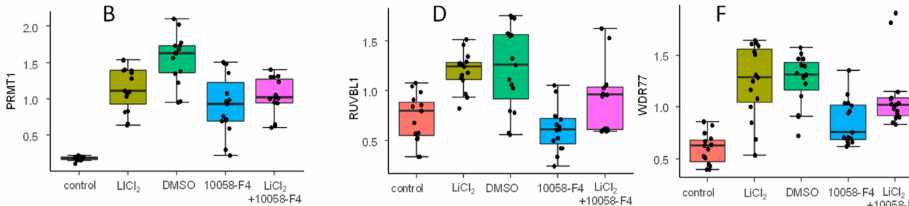
Figure 6. Validation of β -catenin and MYC dependent regulation of three embryonic related targets activated during CML blast crisis: ( A , C , E ) Respective Proximal CHIP-seq signal with binding site bars for MYC and TCF7L2 concerning PRMT1,RUVBL1, WDR77; ( B , D , F ) boxplots of respective QRT-PCR expression for PRMT1, RUVBL1, and WDR77 mRNA after stimulation of BCR-ABL positive hematopoietic progenitors (K562) with LiCl 2 (control as control condition) and with 10058-F4 myc inhibitor (DMSO as control) and combination of the two stimulations, mRNA expression were normalized on GAPDH transcript